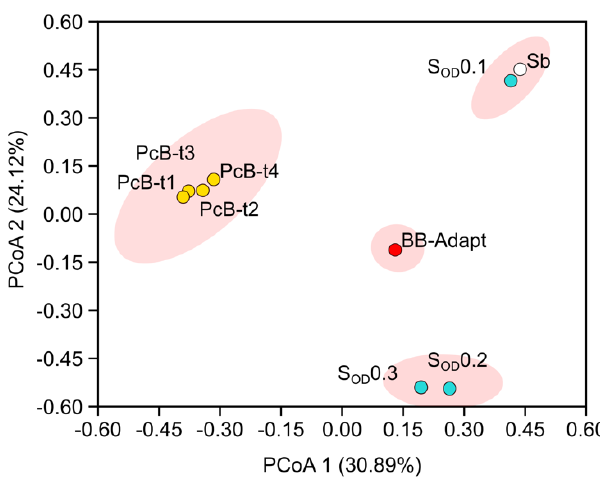
Figure 6. Principal coordinate analysis using the Bray–Curtis phylogenetic distance matrix based on the ASV table. Sb: Bare Soil without treatment. S OD : Rhizospheric soil after application of microbial solution; numbers mean bacterial OD concentration; Bb: Batch bioreactor (complete mix, glucose to citrate finding, and N 2 by air supply) after ten days. PcB: Packed Bioreactors (citrate as the only carbon source and N 2 by air supply) (PcB_t1 = 112, PcB_t2 = 160, PcB_t3 = 200, and PcB_t4 = 240 days).